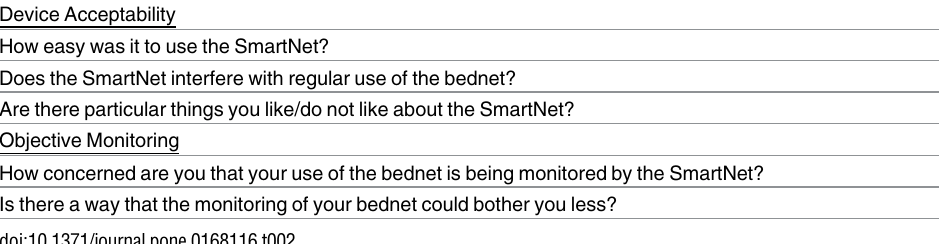
Table 2. Questions about perceptions of SmartNetand experience with use.